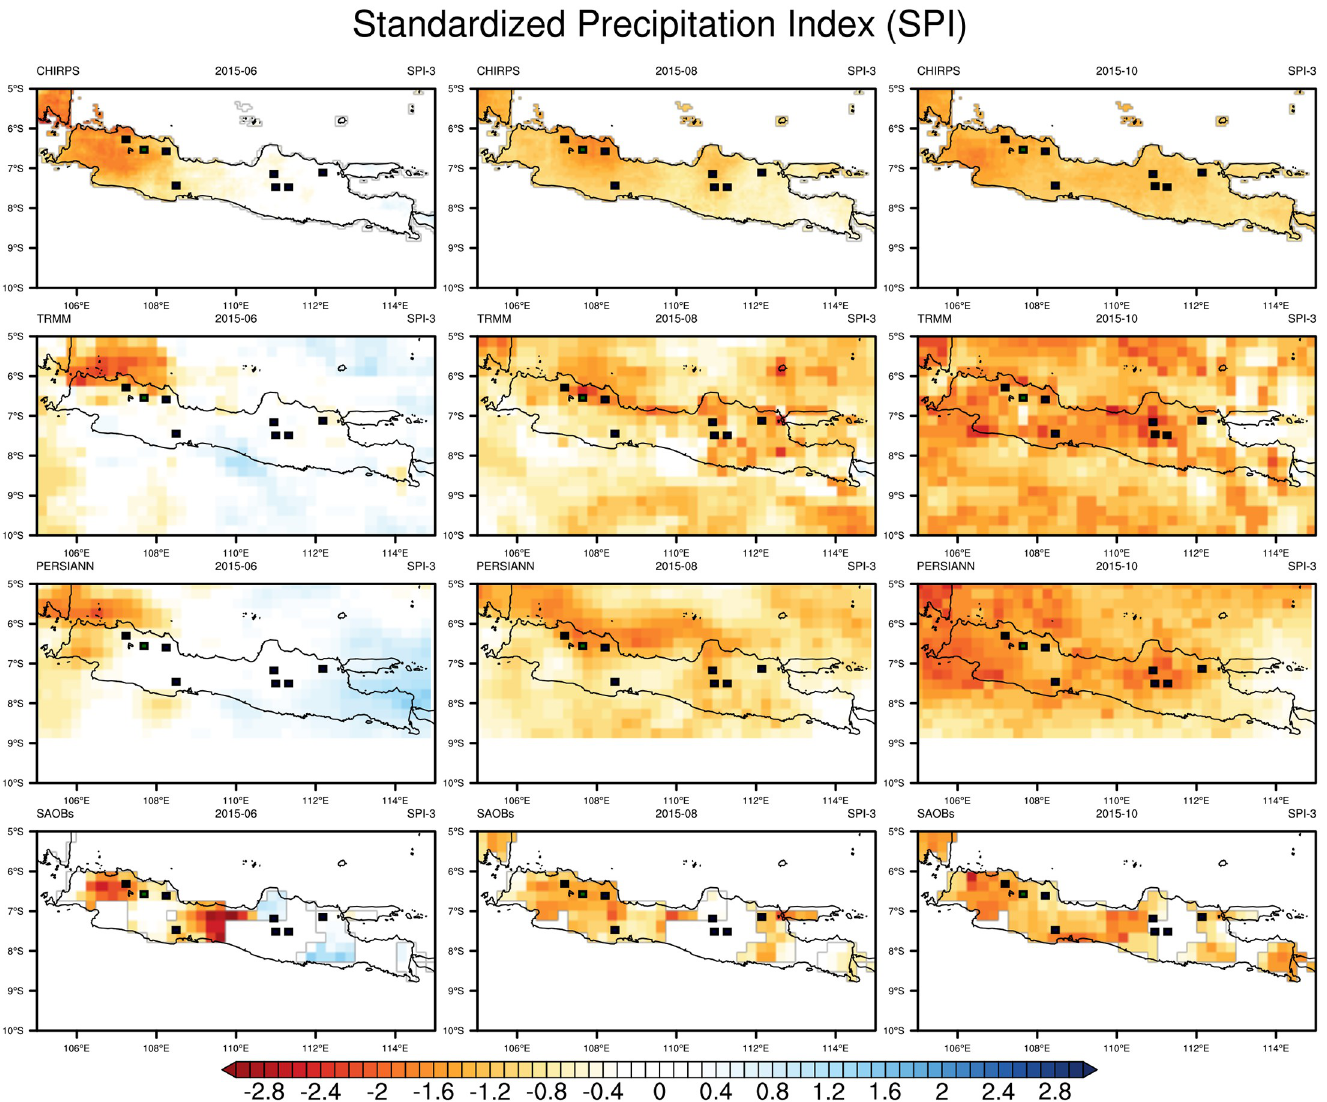
Fig 3. SPI-3 derived from CHIRPS, TRMM, PERSIANN, and SA-OBS for June (left), August (middle), and October 2015 (right) during the drought event due to the 2015–16 El Ni ñ o. Dots on the map indicate the largest rice-producing districts of Indonesia.